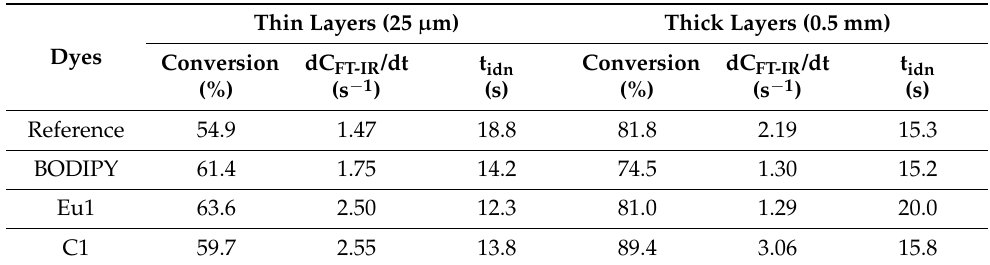
Table 1. Summary of acrylate functional group conversions for radical photopolymerisation processes, following LED at 405 nm irradiation (0.5 mW/cm 2 ) using different dyes.